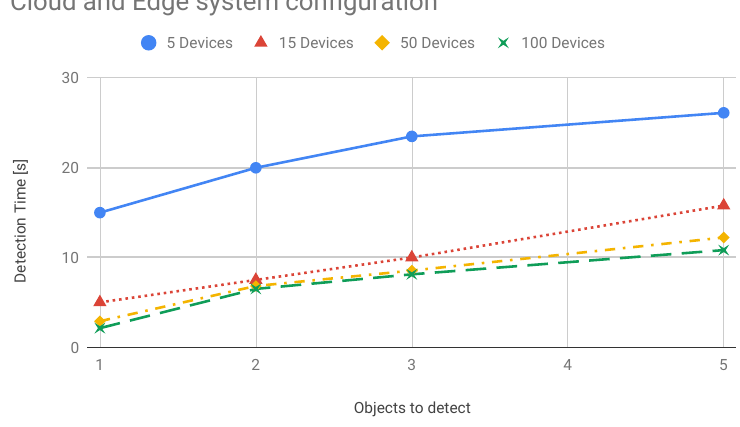
Figure 14. Average detection time vs. edge/cloud system configuration. Edge and cloud nodes are in charge of the tasks needed to perform data analysis coming from sensors devices such as IP cameras.